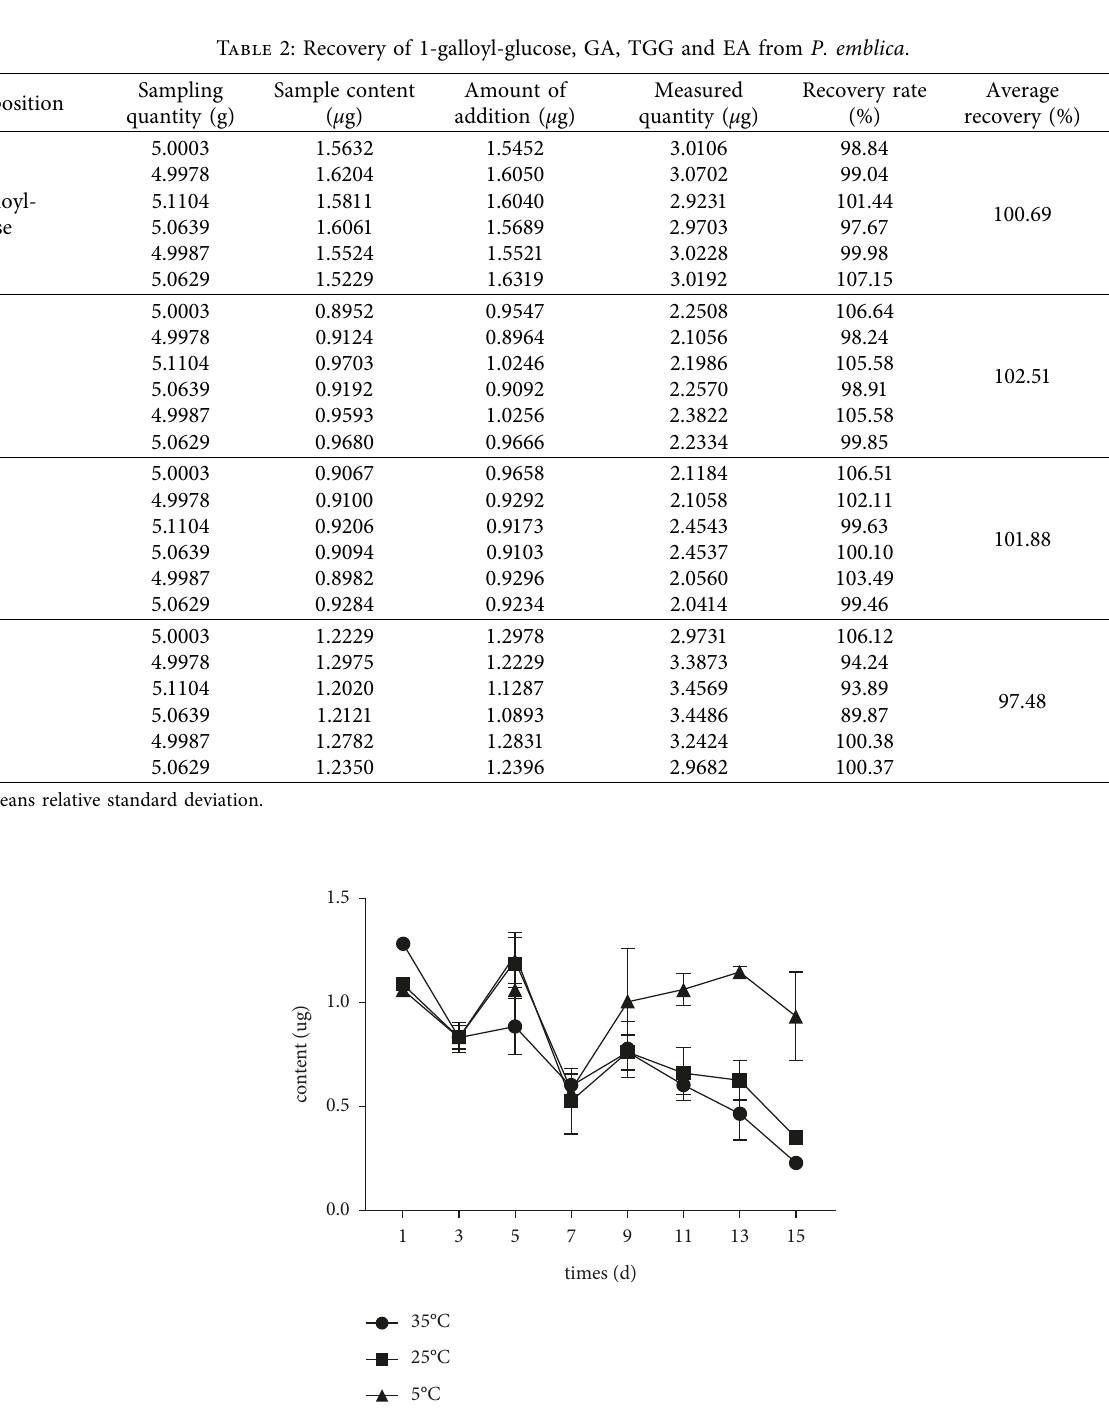
Figure 4: The content change curve at different temperatures of